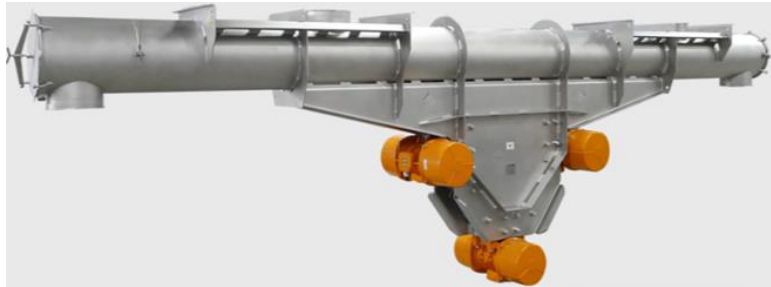
Figure 1. Vibration conveyor with three inertial drives ( “GEA Group AG”